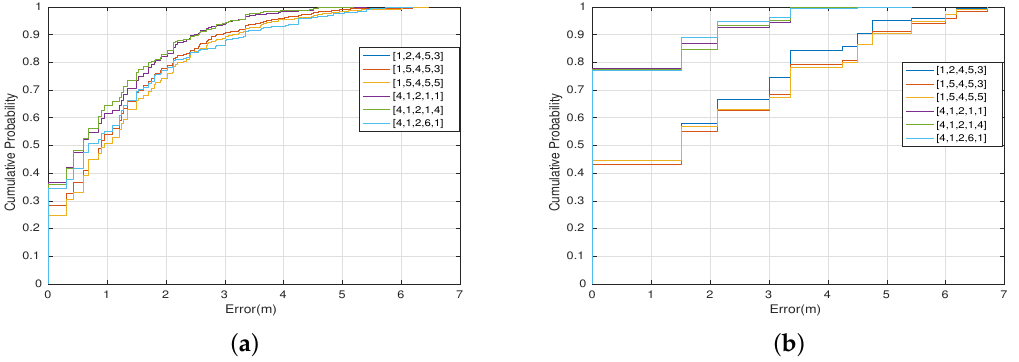
Figure 12. Positioning error for k-NN (with k = 5) using ( a ) weighted distance; ( b ) mode. In both plots, the three best and the three worst combined transmission power for each BLE4.0 beacon are